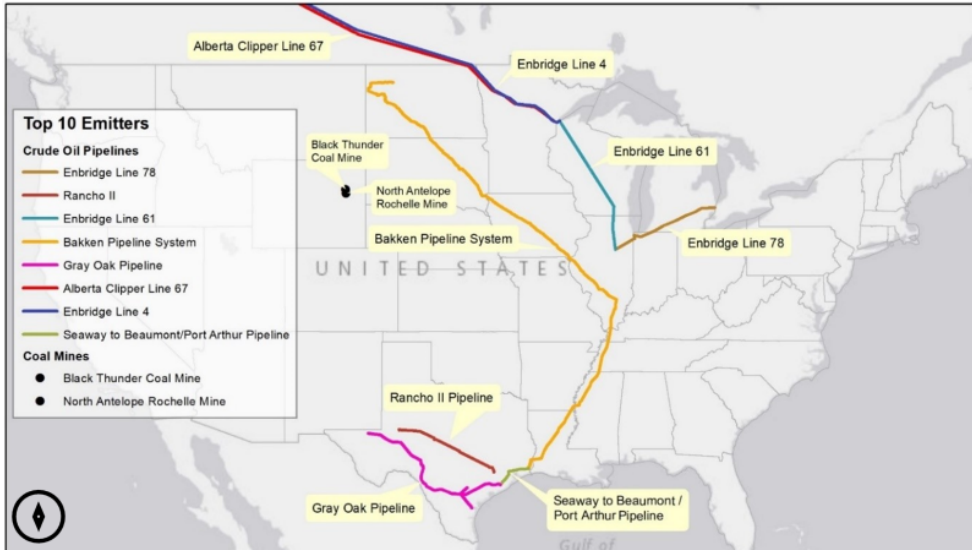
Figure 10. Map of Overall Top 10 CO 2 Point-Source Emitters Across All Fossil-Fuel Industries in the United States (Generating using OpenStreetMap).